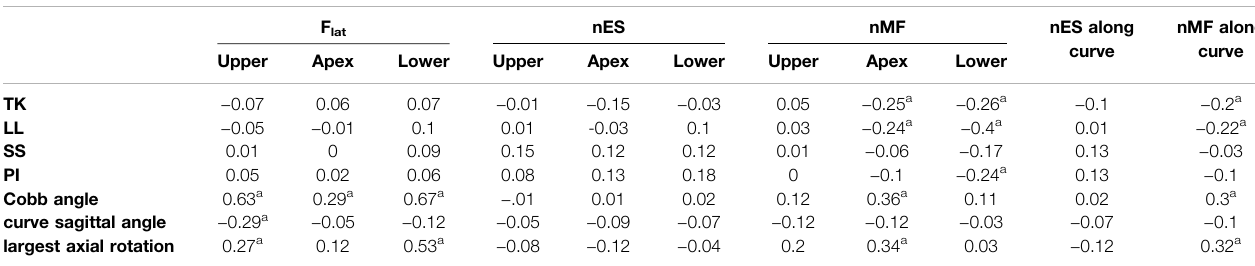
nMF along curve